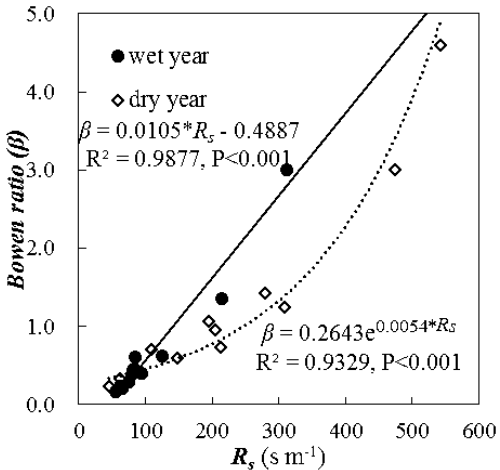
Figure 10. Response of monthly average Bowen ratio ( β) on sur- face resistance ( R s ) in the wet and dry